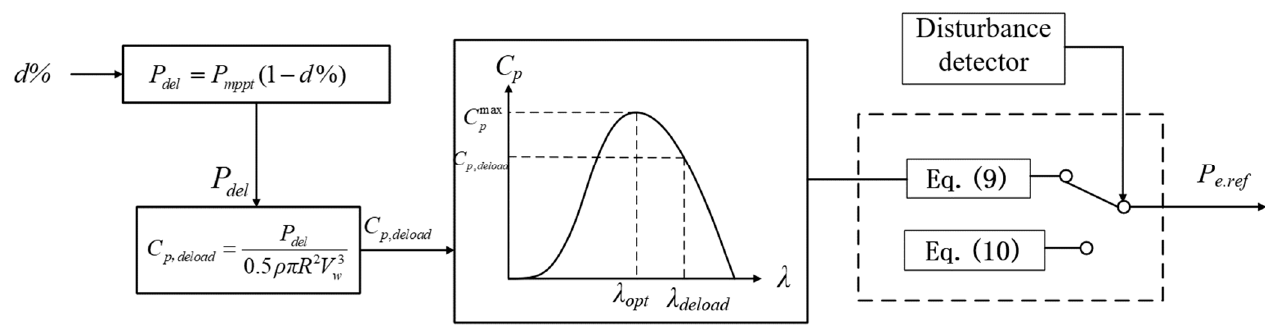
Figure 4. Control diagram of the enhanced frequency response of the DFIG-based over-speed de-loaded curve.